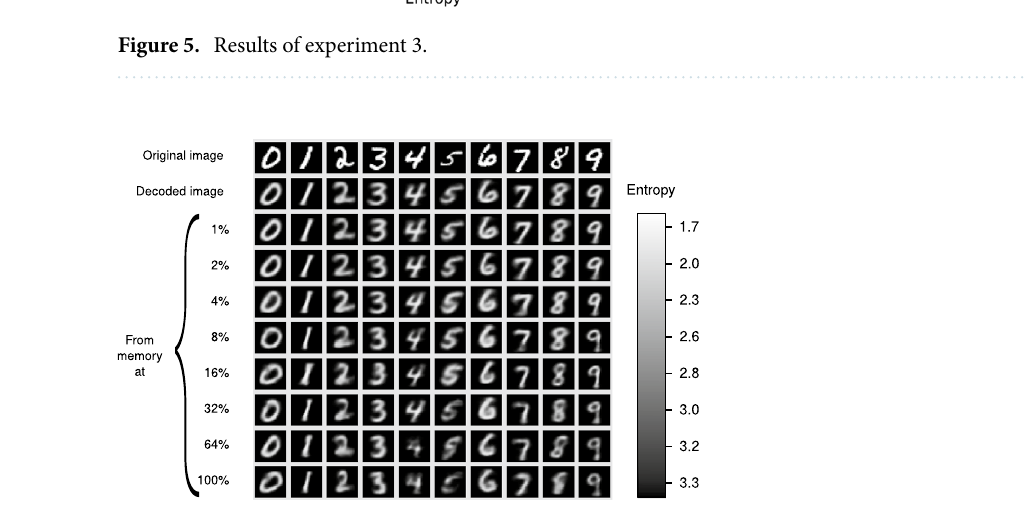
Figure 6. Similarity between the cue and the recovered digits as a function of the